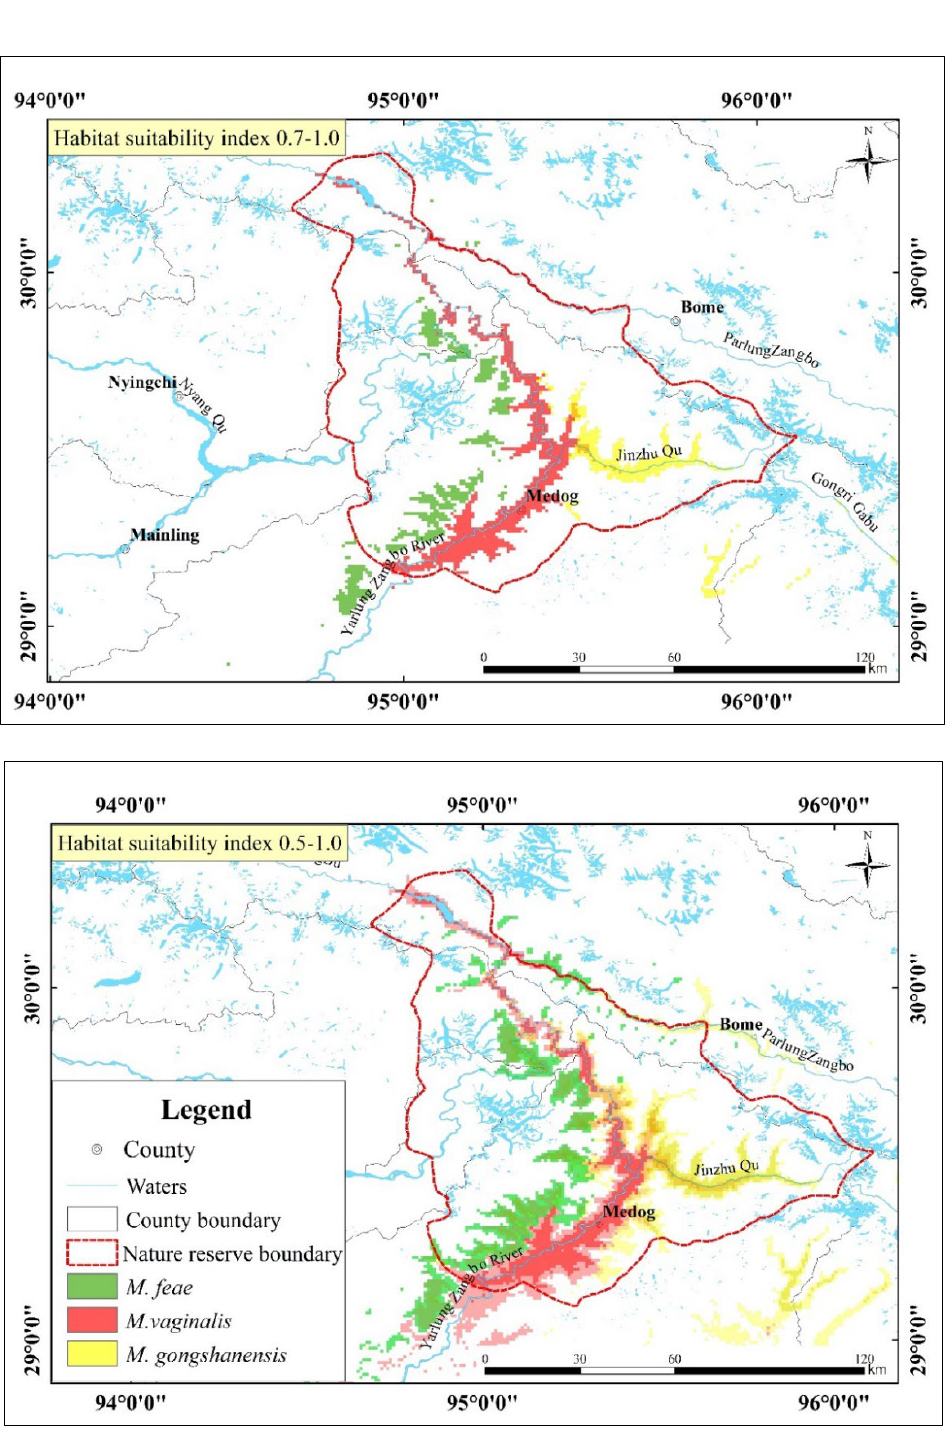
Figure 3. Potential distribution areas of the three muntjac species the Yarlung Zangbo Grand Canyon National Nature Reserve, Tibet.